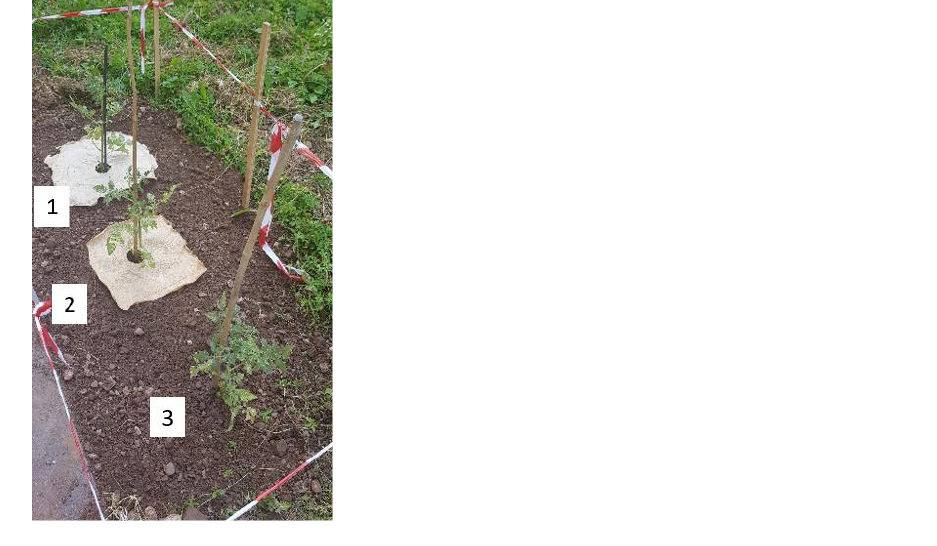
Figure 16. Experimental setup for the tomato plant cultivation with TSC. (1) not crosslinked TSC, (2) crosslinked TSC, and (3) without TSC